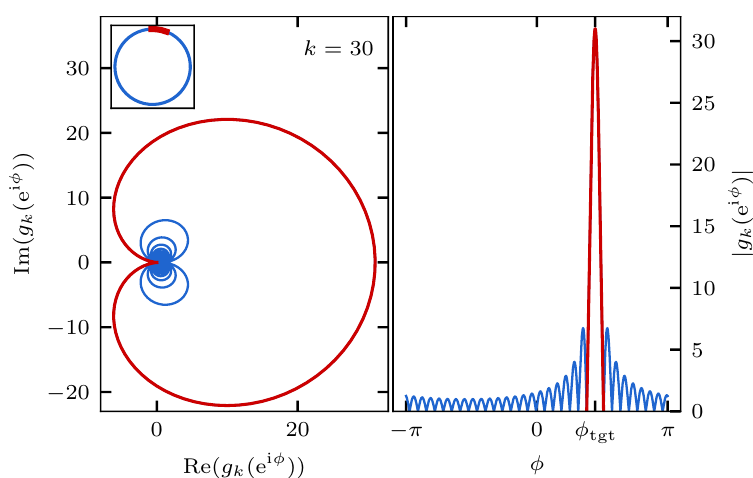
Figure 1: Left: Mapping of the complex unit circle | z | = 1 (inset) by the geometric ( z ) with polynomial order k = 30. The “target” arc of the unit circle high- sum g k lighted in red is mapped to the red line in the main panel by g value of the mapped values as a function of phase angle φ . The part of the curve marked in red is the mapped “target” arc of the unit circle, given by the target phase φ tgt